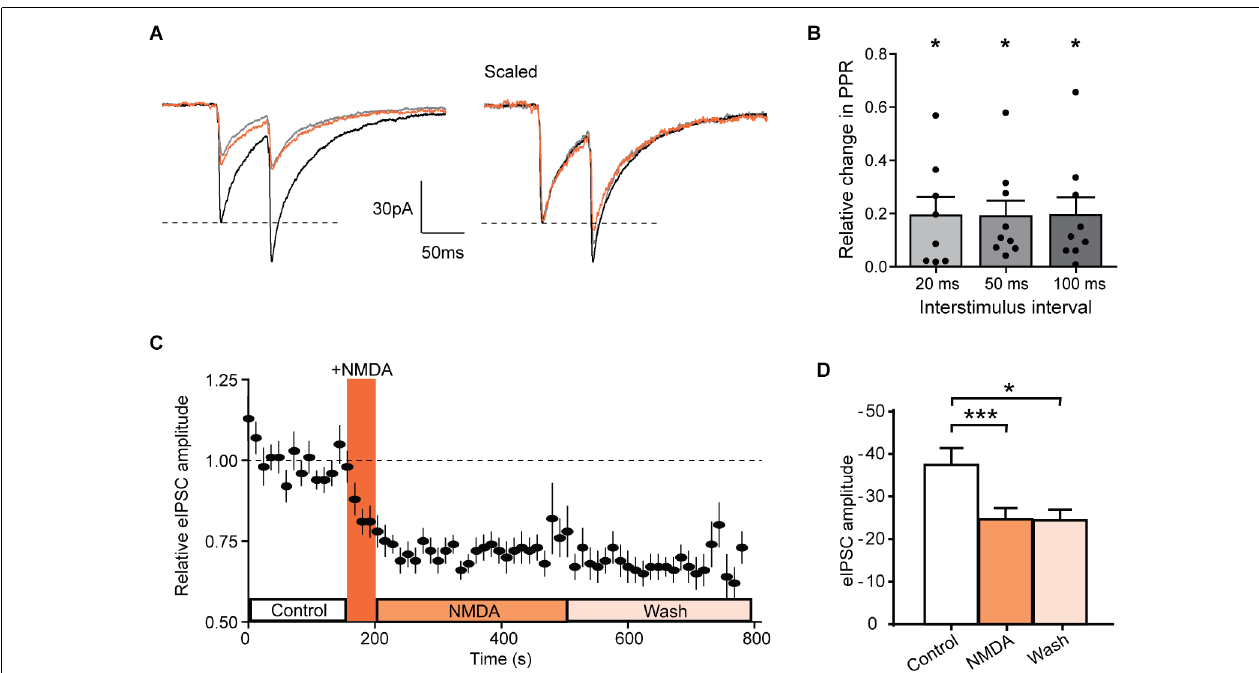
FIGURE 5 | NMDA inhibits evoked IPSCs in GAD-eGFP positive neurons. (A) Average of 10 traces representing the response to two successive stimulations separated by 50 ms before (black, control) and during NMDA application (orange, NMDA) and after a washout (gray, wash). (B) Histograms showing the relative change in PPR measured in GAD positive cells, for three different paired stimulation interval: 20 ms ( N = 8), 50 ms ( N = 9), and 100 ms ( N = 9). (C) Time course of normalized GABAergic eIPSC amplitude before and after NMDA application ( N = 17). (D) Histogram showing average eIPSC amplitude before (control) NMDA application, after NMDA application (NMDA) and after a washout (wash; N = 17). * p < 0.05 and *** p < 0.001. One sample t-test (B) and paired t-test (D) were used. Error bars indicate